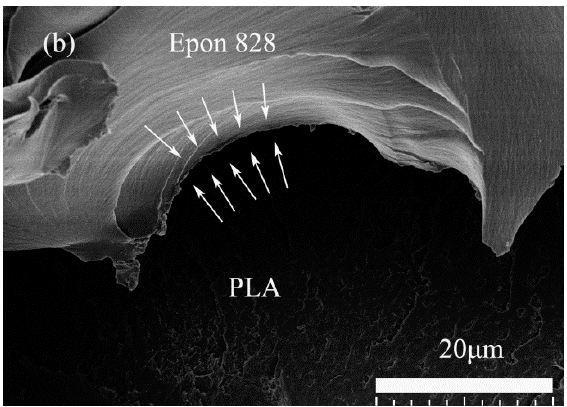
Figure 9. Scanning electron microscope (SEM) images of specimen’s fractured surface of Epon 828 resin and printed PLA braiding structure, with arrows pointing out the edge of these two materials: ( a ) scale of SEM image is 200 µm; ( b ) scale of SEM image is 20 µm. Oppositely, in the PLA/UDMA/TEGDMA system, the UDMA/TEGDMA resin had strong bonding with the printed PLA braiding structure, and even though the specimen fractured, these two materials still cohered together at the fractured surface. Compared to the PLA/Epon 828 system, there is no obvious gap between the two materials, as shown in Figure 10a,b, and the small stripes on the UDMA/TEGDMA surface originated from the materials boundary, not along the boundary. Thus, it is believed that in this system, the printed PLA braiding structure enhanced the UDMA/TEGDMA resin’s compression properties because of the strong inter-phase bonding.